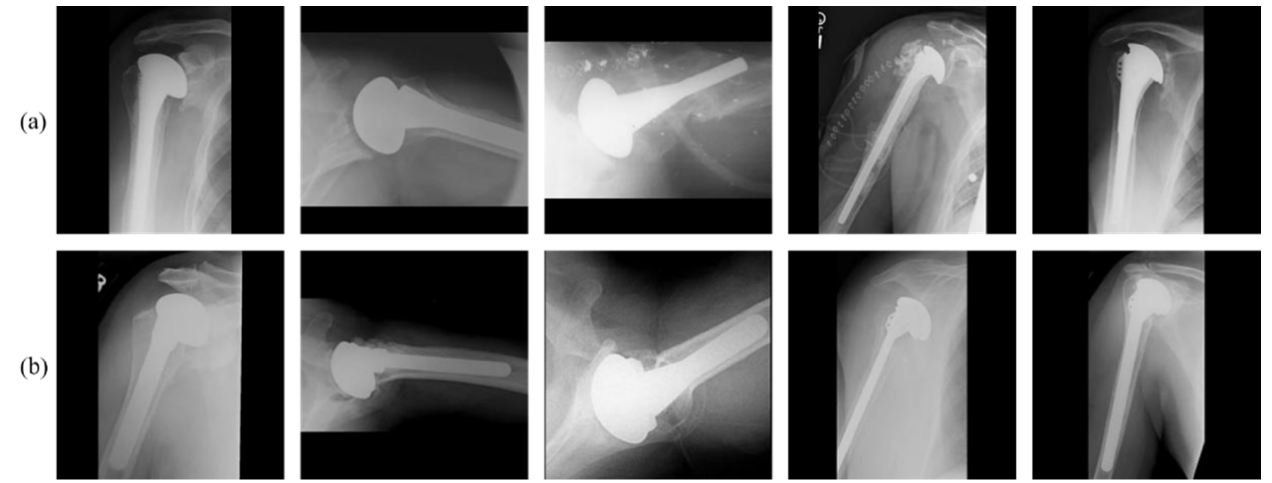
Figure 16. The high inter-class similarity between the two classes: ( a ) class 2 (Depuy) and ( b ) class 4 (Zimmer).